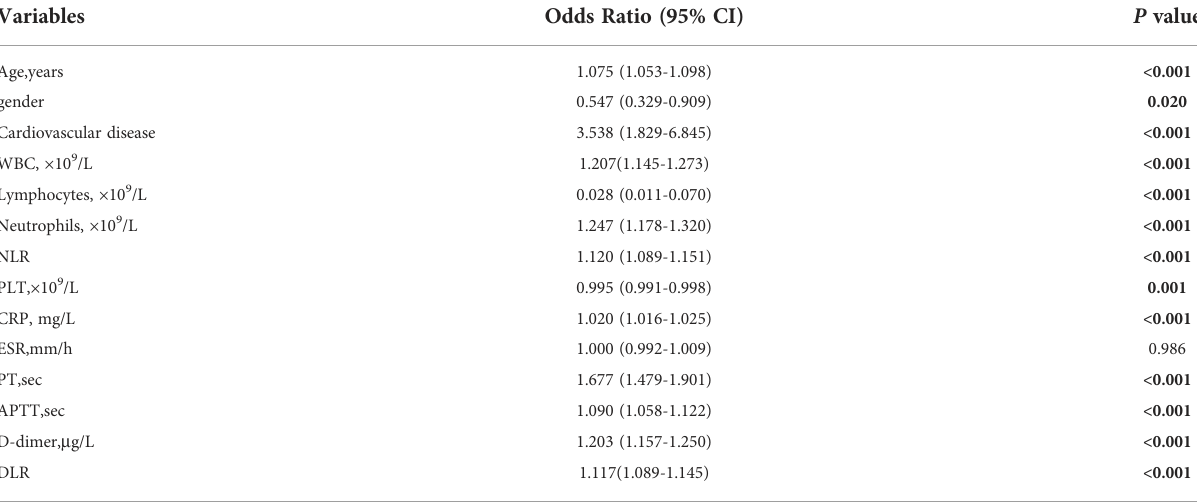
TABLE 3 Univariate analysis of risk factors related to the mortality of COVID-19 patients. Variables